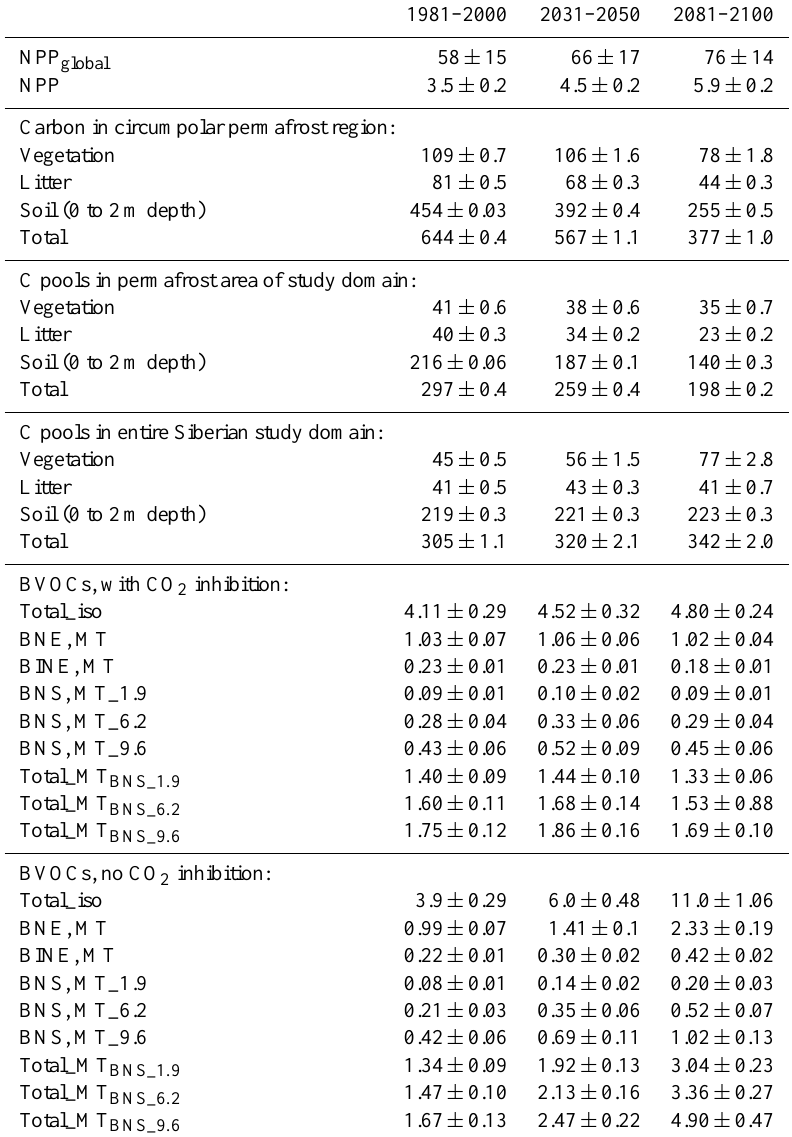
Table 2. Simulated changes in net primary productivity, BVOC emissions, and C pool size in vegetation and soils. Unless stated otherwise, values are for the simulated Siberian domain (76–164 ◦ E, 46–71 ◦ N) and represent an area of 1.2 × 10 7 km 2 . NPP global (given as a reference value) is global vegetation net primary productivity (PgCa − 1 ) . BVOCs are in TgCa − 1 , CO 2 –C fluxes in PgCa − 1 ; C pools are in PgC. Simulations for monoterpene emissions for the boreal needleleaf summergreen (BNS) plant functional type compared three cases (indicated as different subscripts for “Total_MT BNS ”), using maximum (9.6µgCg − 1 h − 1 ) and minimum (1.9µgCg − 1 h − 1 ) values for E ∗ measured in Spasskaya Pad (see text) and E ∗ = 6 . 2µgCg − 1 h − 1 as a weighted average from all observations at the Spasskaya Pad location. For BVOCs, CO 2 inhibition was switched on and off (Arneth et al.,